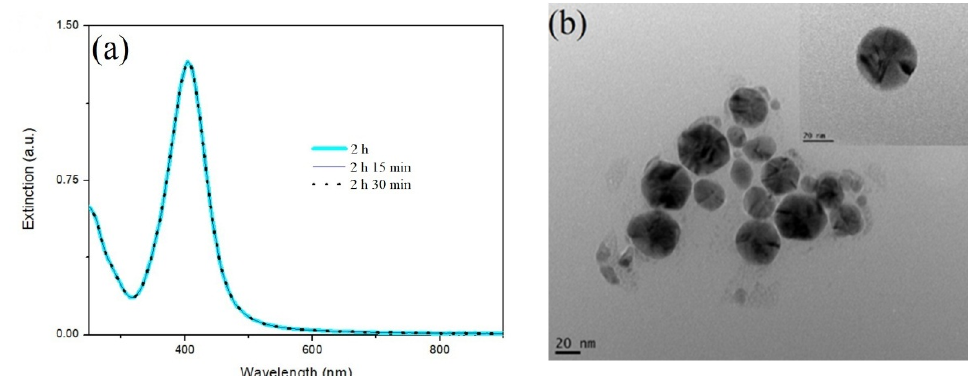
Figure 1. ( a ) UV-Vis spectra and ( b ) TEM images of quasi-spherical Ag NPs synthesized by LED irradiation. The LSPR band of the quasi-spherical Ag NP colloids peaked at 415 nm, and the intensity was not further increased for longer irradiation.